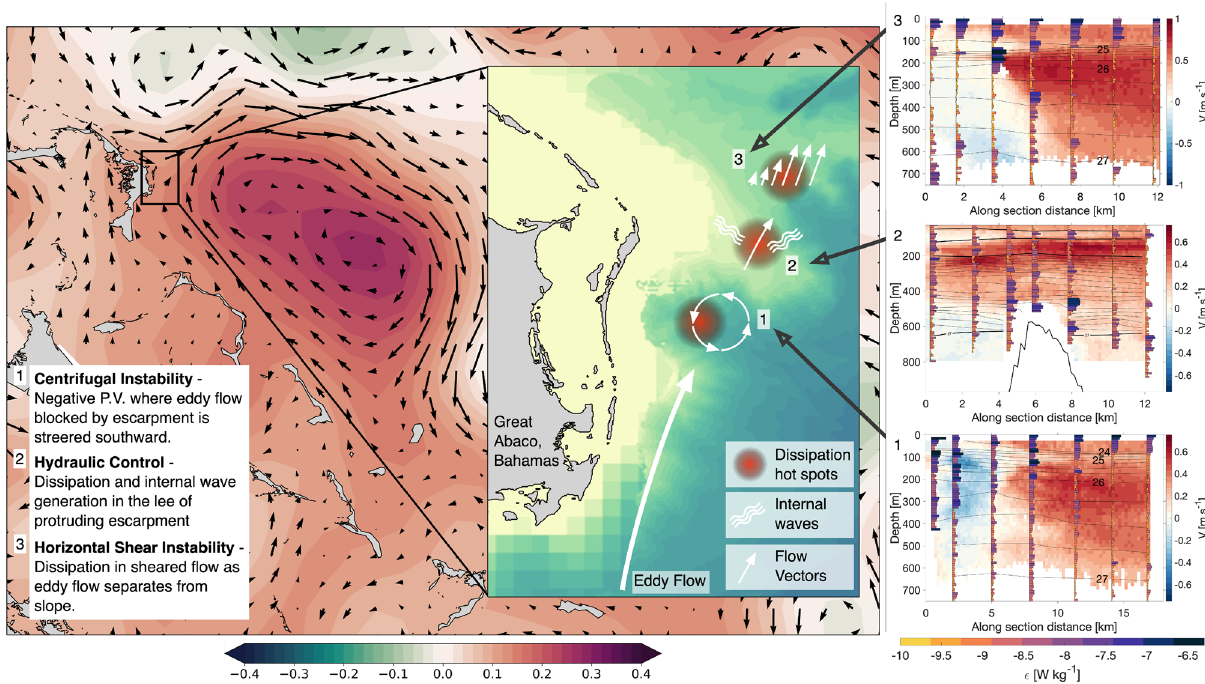
Figure 1. Eddy flow topography interactions. A schematic representation of the varied interactions between the flow of an anticyclonic eddy and the steep and rough slope offshore of Great Abaco, Bahamas. The large panel shows the sea level anomaly (SLA; contours) from October 31 2017 and associated surface geostrophic flow (black arrows). The positive SLA anomaly is an anticyclonic eddy impinging on the eastern slope of the Lucayan Archipelago. The inset panel shows the bathymetry (yellow–blue contours) for a region where the MeRMEED fieldwork took place, and highlights the key regions of eddy flow-topography interactions: (1) Generation of centrifugal instability; (2) Hydraulic control; (3) Generation of horizontal shear instability. The three right hand panels show vessel mounted acoustic Doppler current profiler-based meridional velocity (V) and density (black contours) in each of the three key regions. The stacked bar plots show vertical microstructure-based − 10 Wkg − 1 estimates of the turbulent dissipation in 10 m bins. Each are scaled by 10 , and the colour represents the dissipation rate with a logarithmic scale. For more details see Evans et al. 16 . The maps were created